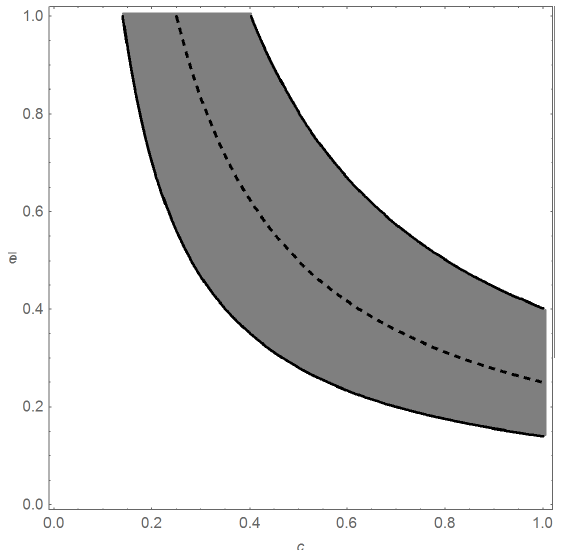
Figure 2. Region in the ( c , ¯ e ) − space where in a three-player contest e L 1 > e NE —that is, the L1 level of effort is greater than the Nash equilibrium level. The dashed line is condition ¯ ec = 1